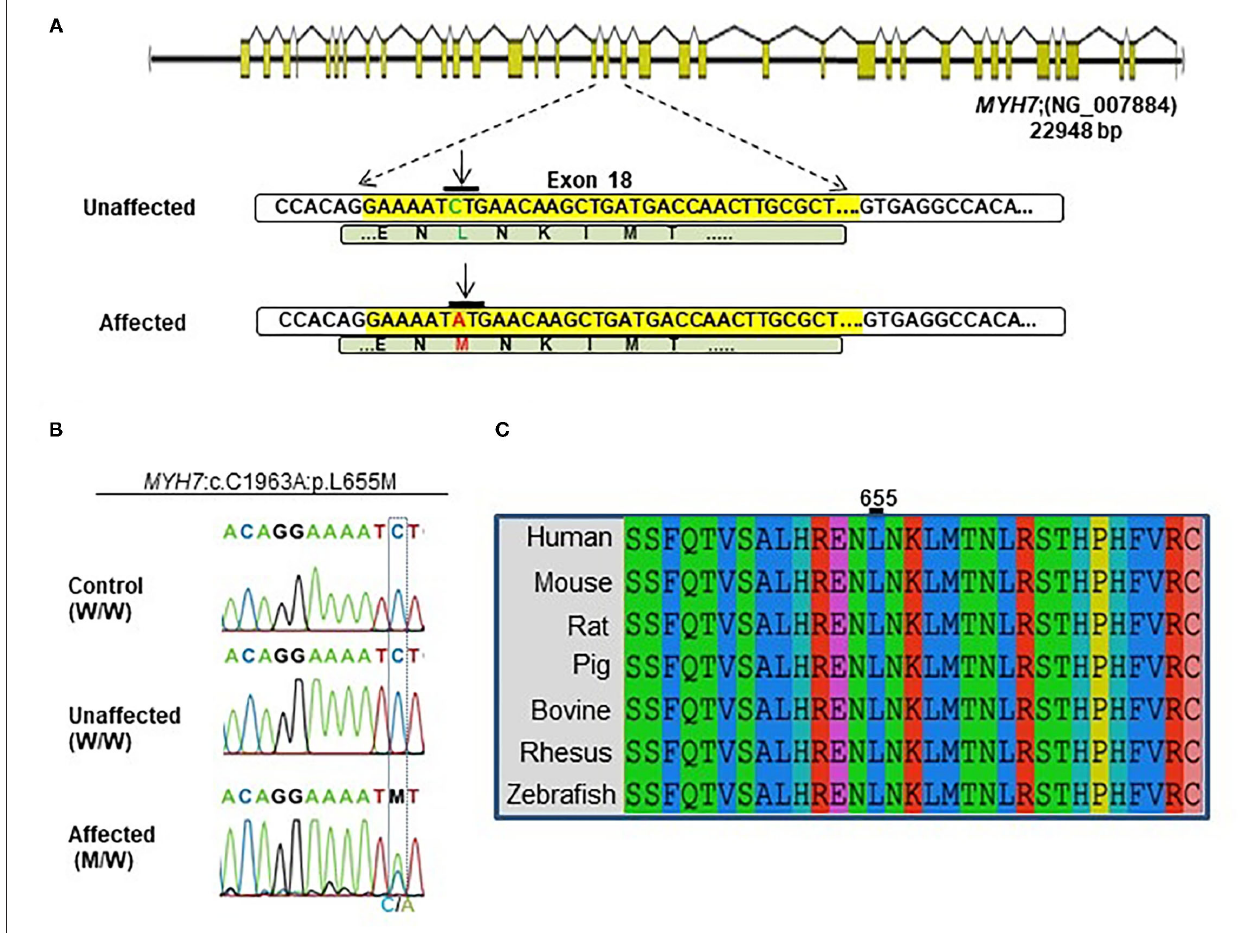
FIGURE 2 | Identification of the MYH7 heterozygous variant in the selected Iranian family. (A) Schematic diagram shows the human MYH7 locus and the enlarged sequences of exon 18 of this locus, along with the sequences of the MYH7 variation. The yellow region is the exon 18 sequences from MYH7 . Green letters are wild-type DNA and the amino acid motif in the unaffected family members. Red letters indicate the substituted (C–A) target nucleotide in the MYH7 and the p.Leu655Met alleles in the affected family members. (B) Sequence chromatograms of the MYH7 novel variant loci which were found in this study. The results of Sanger sequencing from affected, unaffected, and control DNA samples confirmed that the variation was inherited from one of the parents in a heterozygous pattern. (C) Evolutionary conservation of MYH7 in the actin-binding site domain shows that this region of protein is highly conserved throughout all species, especially in